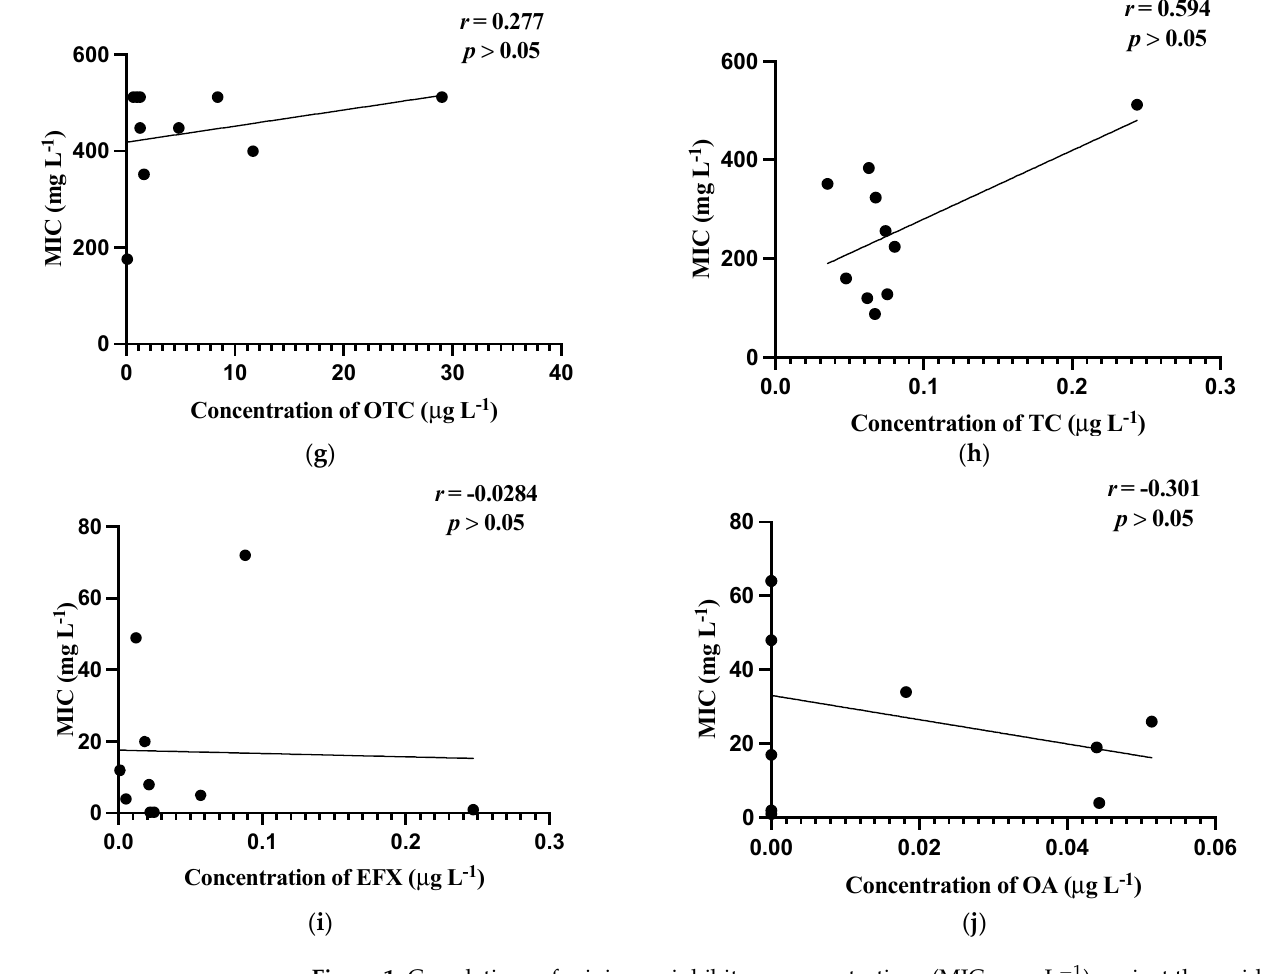
Figure 1. Correlations of minimum inhibitory concentrations (MICs, mg L − 1 ) against the residual concentrations of antibiotics (µg L − 1 ). ( a ) MIC (mg L − 1 ) of Aeromonas spp. against concentration (µg L − 1 ) of doxycycline; ( b ) MIC (mg L − 1 ) of Aeromonas spp. against concentration (µg L − 1 ) of oxytetracycline; ( c ) MIC (mg L − 1 ) of Aeromonas spp. against concentration (µg L − 1 ) of tetracycline; ( d ) MIC (mg L − 1 ) of Aeromonas spp. against concentrations (µg L − 1 ) of enrofloxacin; ( e ) MIC (mg L − 1 ) of Aeromonas spp. against concentrations (µg L − 1 ) of oxalinic acid; ( f ) MIC (mg L − 1 ) of Pseudomonas spp. against concentrations (µg L − 1 ) of doxycycline; ( g ) MIC (mg L − 1 ) of Pseudomonas spp. against concentrations (µg L − 1 ) of oxytetracycline; ( h ) MIC (mg L − 1 ) of Pseudomonas s spp. against concentrations (µg L − 1 ) of tetracycline; ( i ) MIC (mg L − 1 ) of Pseudomonas spp. against concentrations (µg L − 1 ) of enrofloxacin; ( j ) MIC (mg L − 1 ) of Pseudomonas spp. against concentrations (µg L − 1 ) of oxalinic acid.